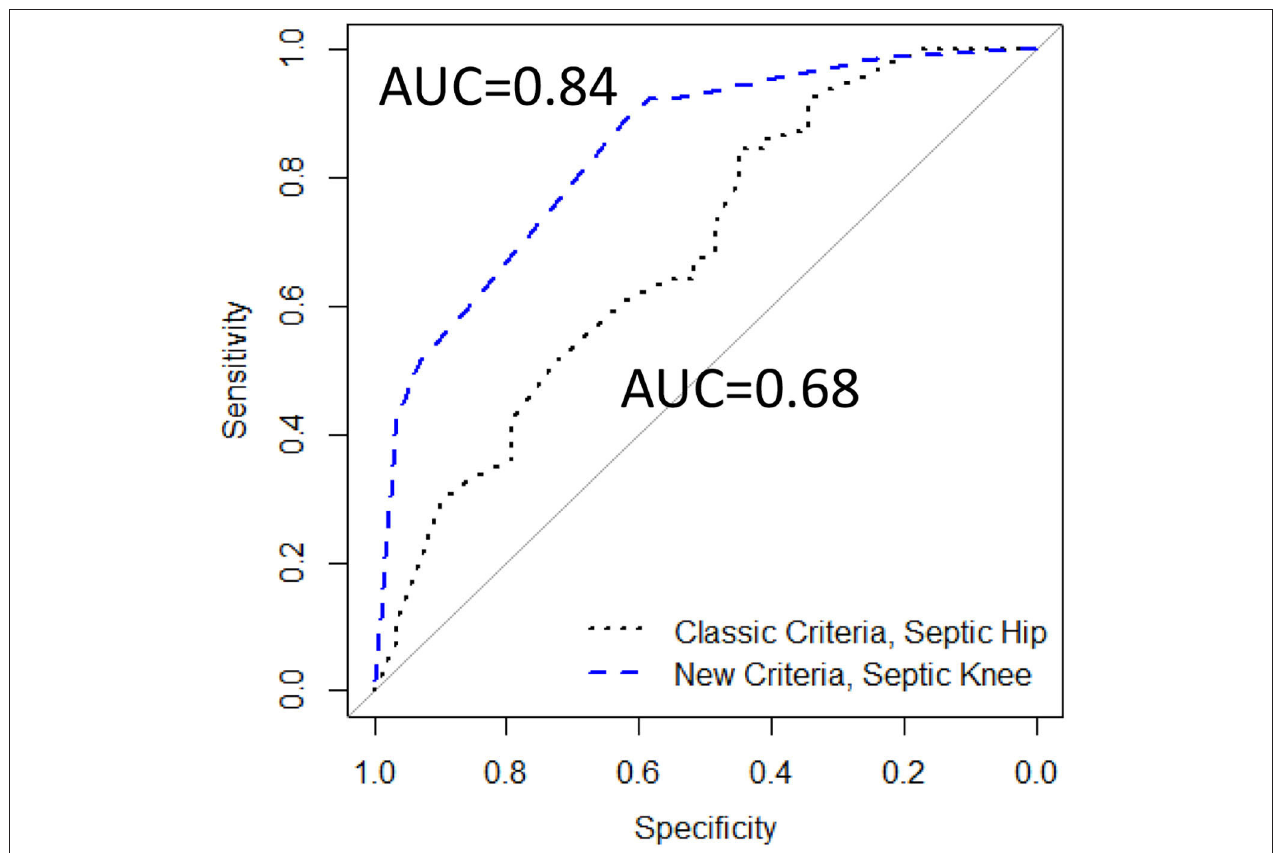
FIGURE 6 | The ROCs comparing Classic Criteria model (117 patients) to a modified New Criteria model containing age, CRP, and %PMN (93 patients), AUC, area under the curve.